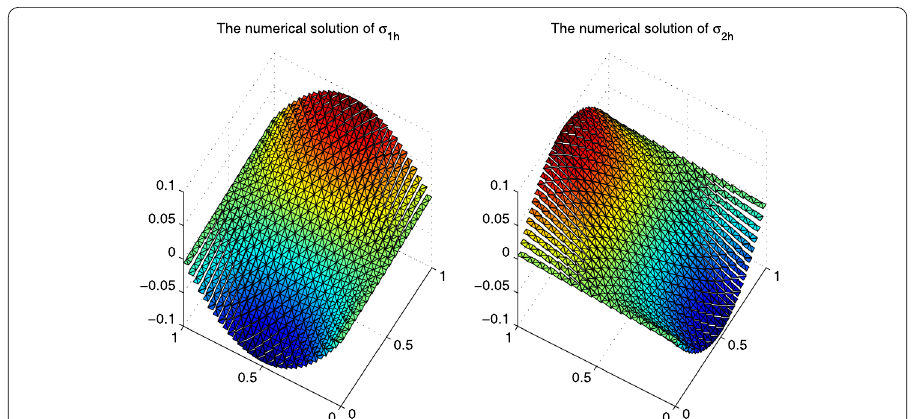
Figure 6 The numerical solution of σ h = ( σ 1 h , σ 2 h